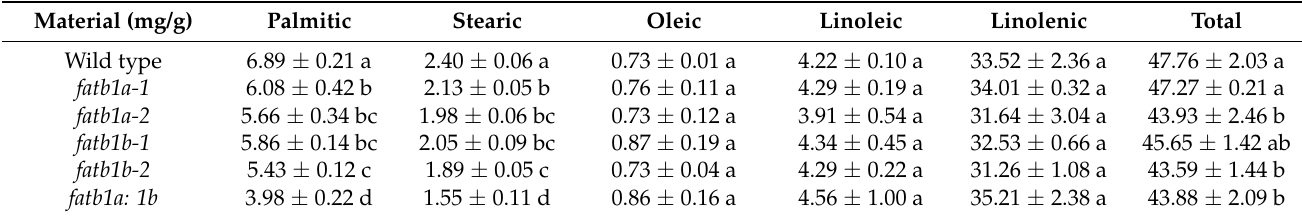
Table 1. Leaf fatty acid content of the different materials.